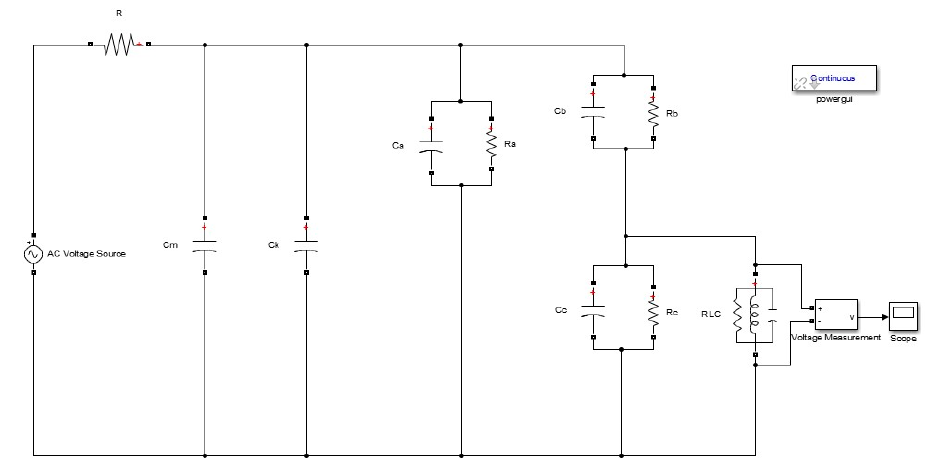
Figure 12. Capacitive resistance PD model.